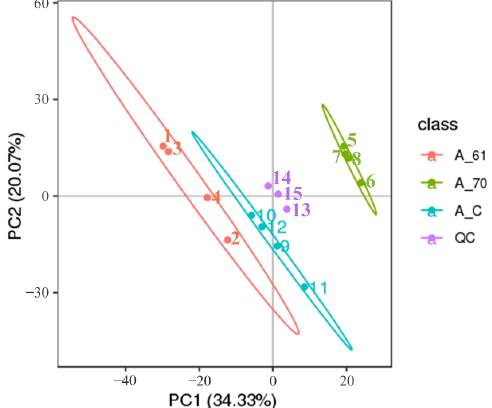
Figure 8. PCA analysis of total samples (A_61 represented mutant 61 with low SW yield, A_C represented the original strain, A_70 represented mutant 70 with high SW